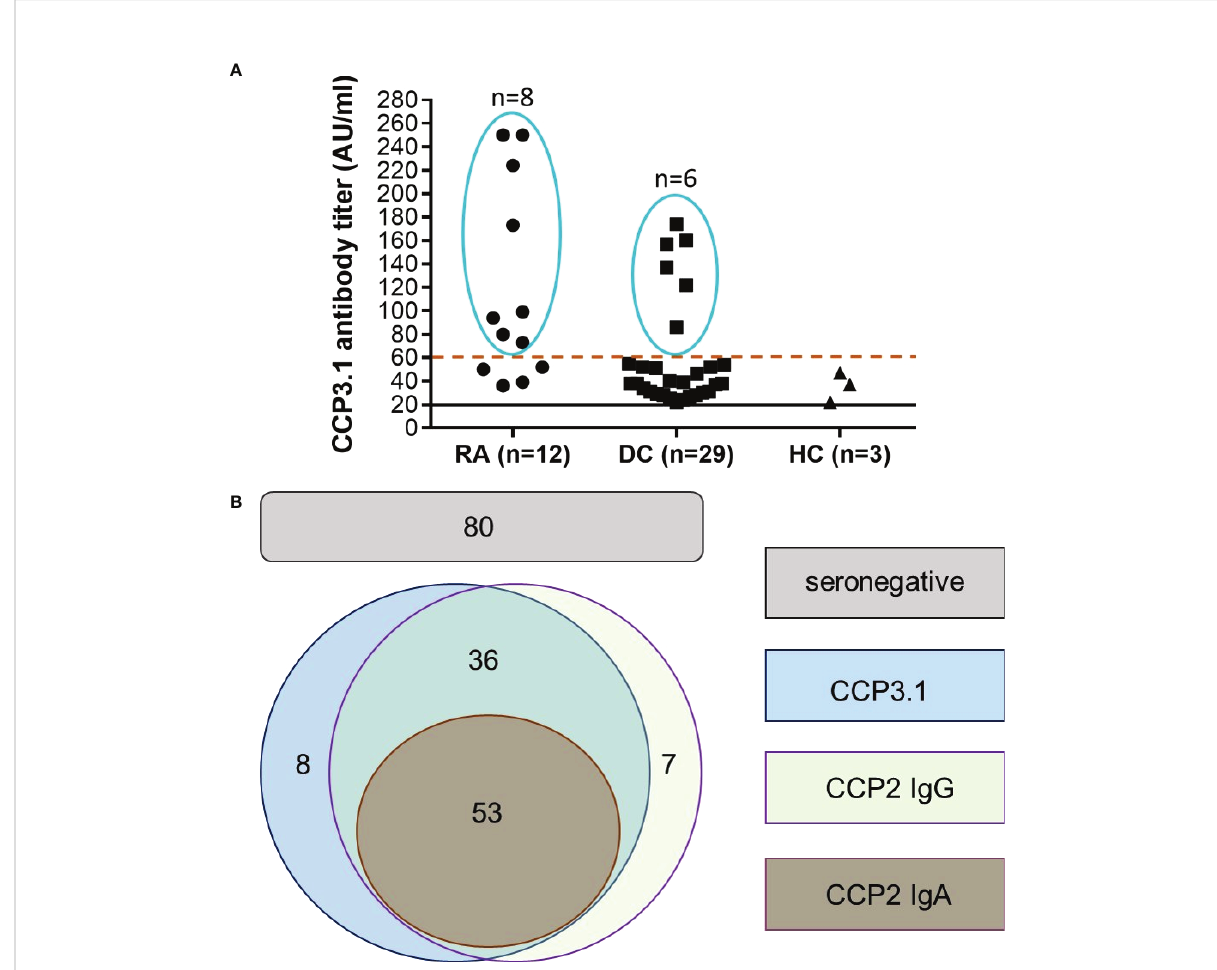
FIGURE 1 Anti-CCP2 IgG, CCP2 IgA and CCP3.1 IgG/IgA antibodies in early RA patients and disease controls. (A) Anti-CCP3.1 antibody levels in anti- CCP3.1 positive/anti-CCP2 IgG negative early RA patients, disease controls (DC) and healthy controls (HC). When applying a cut-off level of 60 AU/ml (high positive), the number of positive disease controls and healthy controls was reduced from 29 to 6 and from 3 to 0, respectively, while 8 out of the 12 anti-CCP2 negative early RA patients remained positive. (B) Schematic representation of the overlap of anti-CCP2 IgG, anti-CCP2 IgA and anti-CCP3.1 IgG/IgA positivity in the early RA cohort when applying the high positive cut-off (60 AU/ml) for the anti-CCP3.1 assay. Out of 184 patients, 53 were found being triple positive for anti-CCP2 IgG, IgA and anti-CCP3.1, 36 patients were double positive for anti- CCP2 IgG and anti-CCP3.1; 7 patients were solely positive for anti-CCP2 IgG and 8 patients for anti-CCP3.1. Eighty patients were negative in all assays